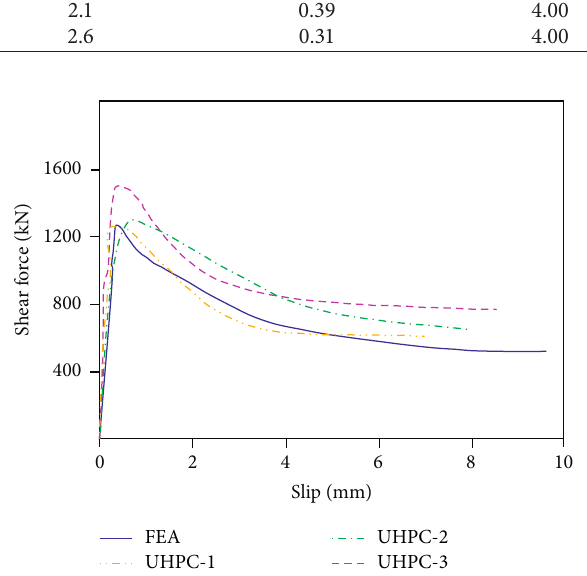
Figure 19: Comparison between numerical load-slip curves and test